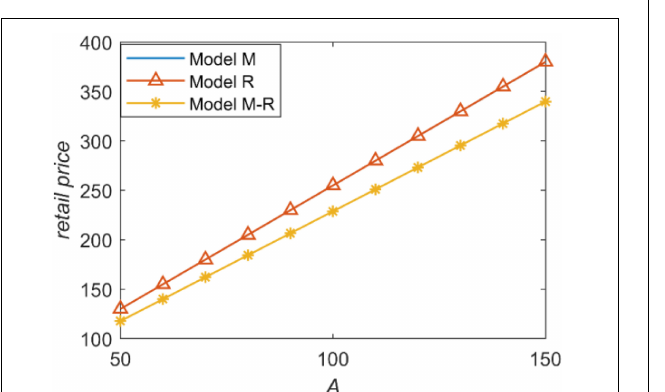
FIGURE 5 | The retailer’s profit with prediction accuracy.